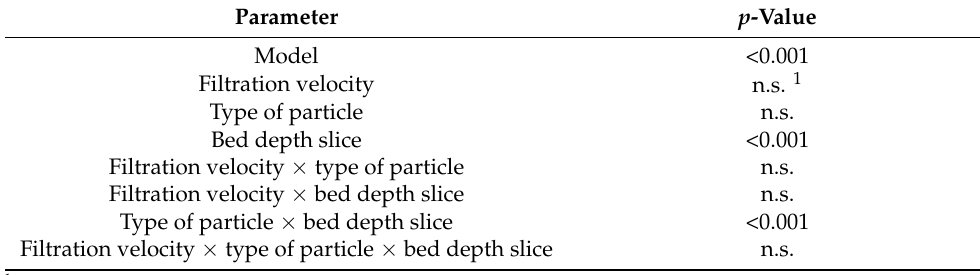
Table 4. Significance levels ( p -value) of the statistical model, each factor (filtration velocity, type of particle, and bed depth slice) and the double and triple interactions for explaining the percentage of the total suspended solids retained in each slice.